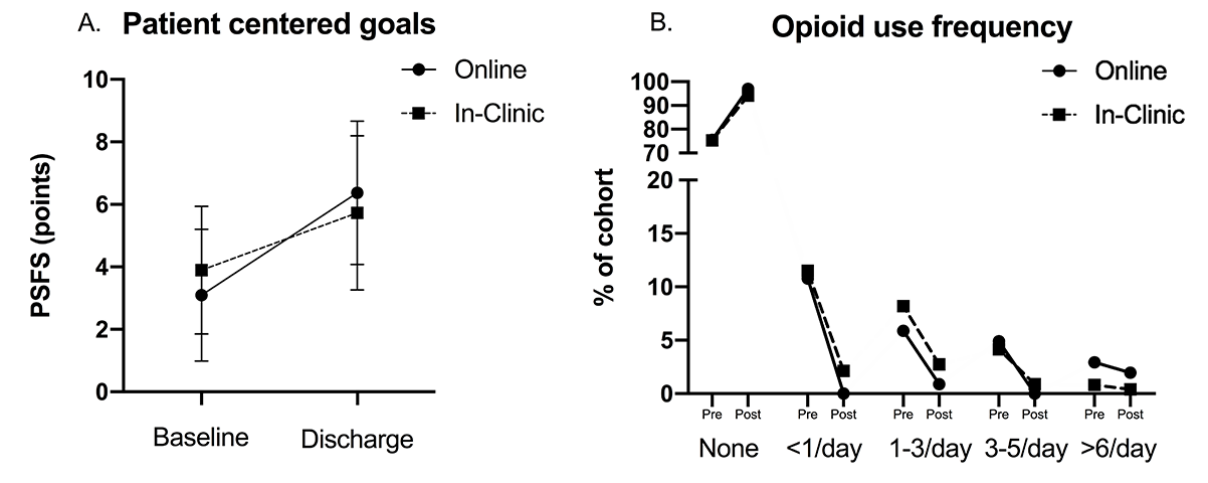
Figure 3. Means and standard deviations for patient opioid use frequency (A) and goal achievement (B) between O-IPU (online) and C-IPU (in-clinic) groups at treatment baseline and discharge. IPU: integrated practice unit; PSFS: patient-specific functional